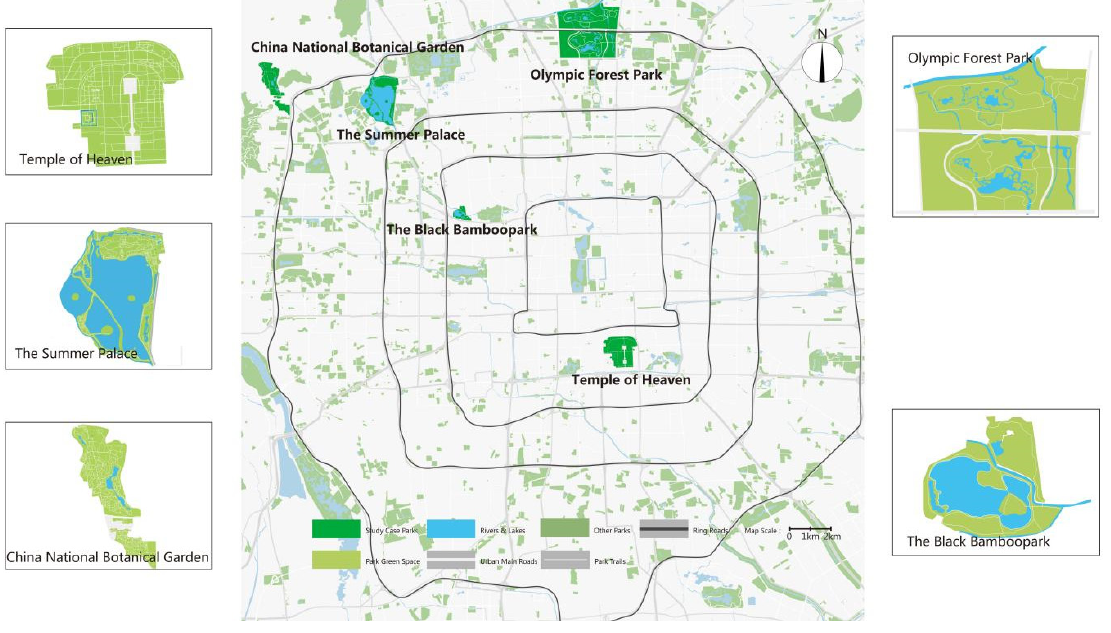
Figure 3. Locations of case